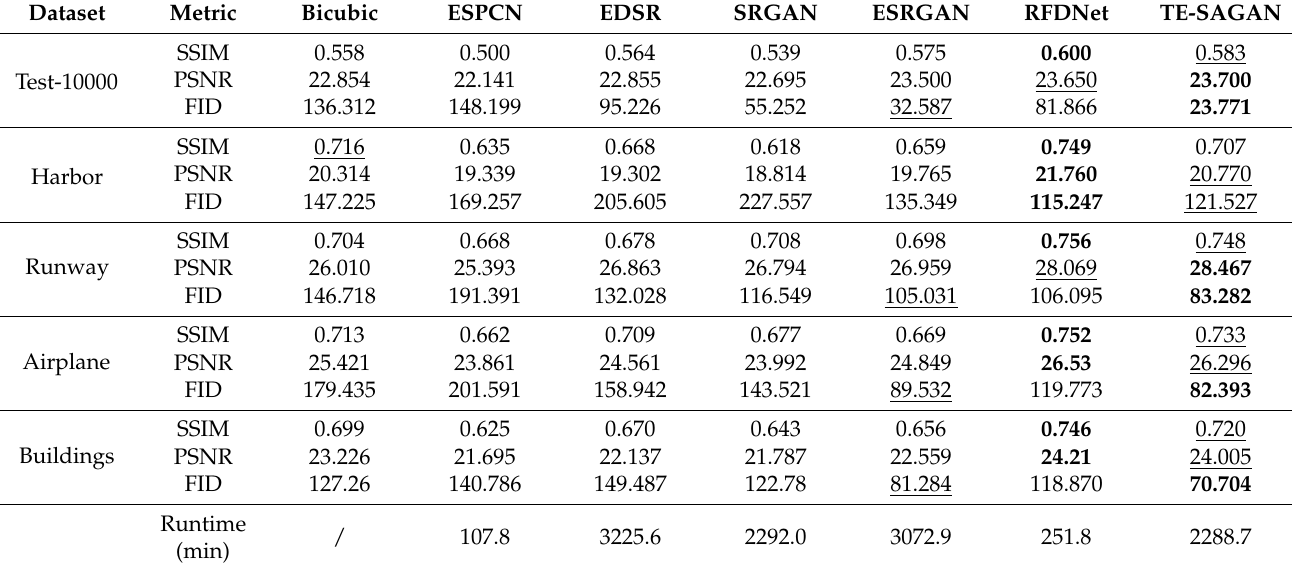
Table 2. Comparison of Bicubic, ESPCN, EDSR, SRGAN, ESRGAN, RFDNet and TE-SAGAN on the Test-10000 set and part of UC Merced Land